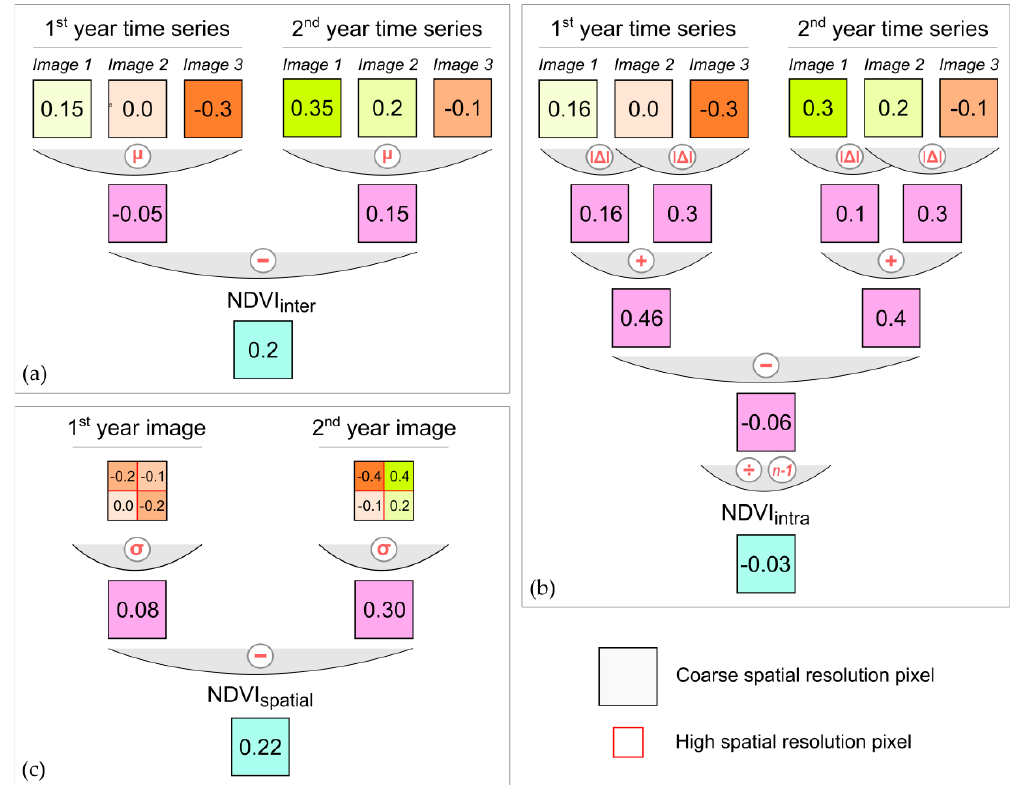
Figure 4. Schematic representation of the calculation of the three landscape metrics at the pixel level: ( a ) example of calculation of NDVI inter from two time series of three images each, where μ corresponds to the annual mean of the pixel values; ( b ) example of calculation of NDVI intra from two time series of three images each (i.e., n = 3 ), where |Δ| correspon ds to the absolute differences between each pair of consecutive images in the annual time series; ( c ) example of calculation of NDVI spatial from two high spatial resolution images (in this example a coarse-resolution pixel contains four high-resolution pixels), where σ corresponds to the standard deviation of the high-resolution pixel